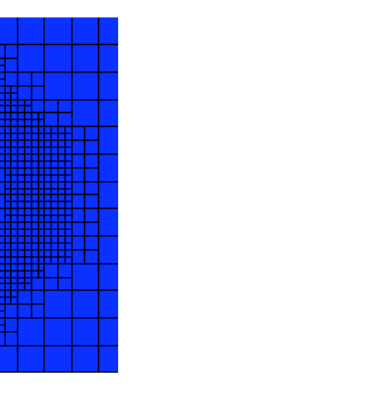
Figure 8 . The first principle stress versus the first principle strain at a point which becomes fully dam- aged (left) and the corresponding time series of the damage variable and Helmholtz free energy density (right). Dynamic effects can be observed in both data sets. On the right, region I corresponds to the response before damage evolution, region II to the brief period of damage evolution, and region III to the period when the material is fully damaged.